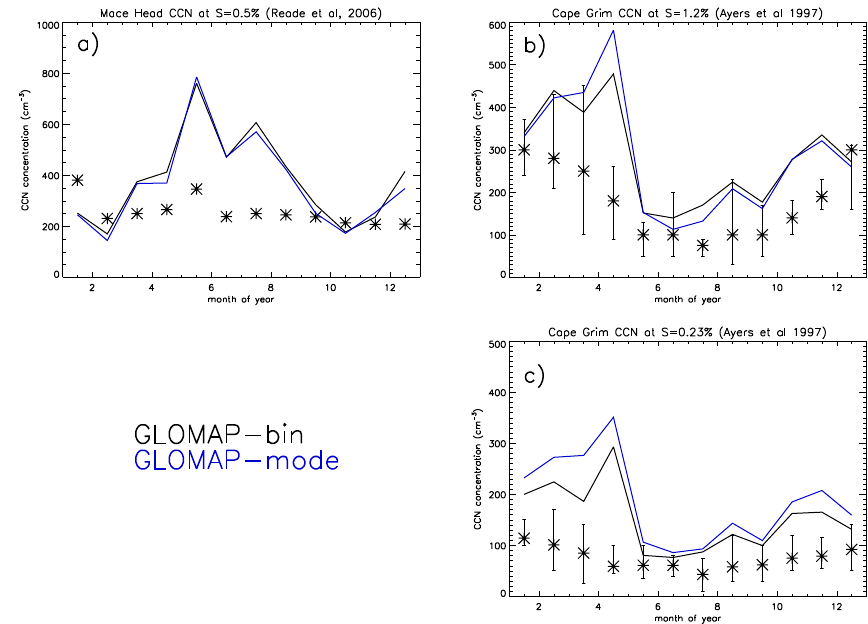
Fig. 17. The simulated annual cycle of CCN concentrations (solid lines) against observations (asterisks) at Mace Head and Cape Grim. The measurements at Mace Head (a) are with 0.5% superstaturation (Reade et al., 2006) whilst the comparison at Cape Grim is shown for measured CCN concentrations at supersaturations of (b) 1.2% and (c) 0.23%, see Ayers and Gras (1991). Vertical bars around the Cape Grim observations show the observed range from 1981–1989. Solid line shows GLOMAP-bin, dashed line is GLOMAP-mode